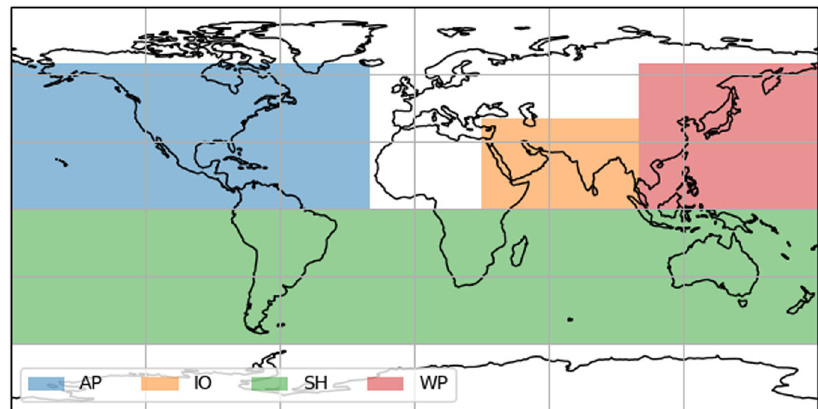
Fig. 4 | Global study regions. North Atlantic/Eastern Paci fi c (AP, blue), North Indian Ocean (IO, orange), Southern Hemisphere (SH, green), Western Paci fi c (WP,